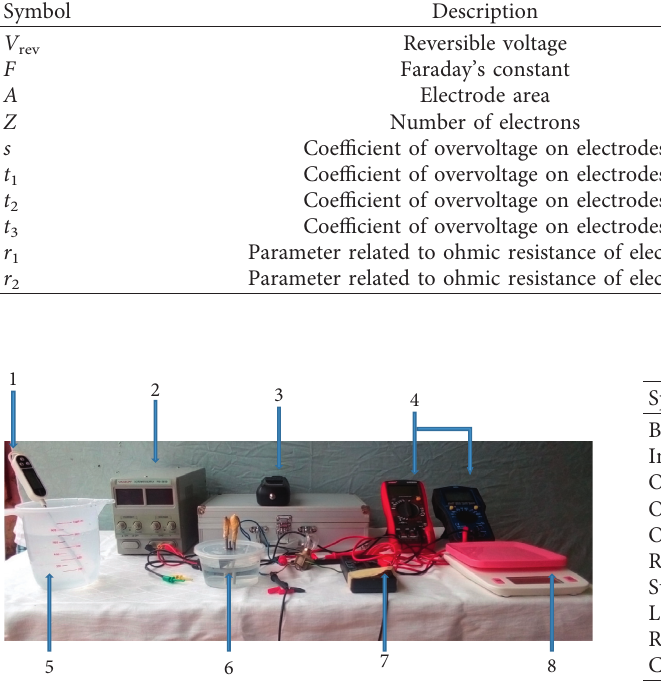
Figure 1: Elements of the experimental setup: (1) digital ther- mometer, (2) DC power supply, (3) hydrogen detector, (4) volt- meters, (5) plastic beaker, (6) cell, (7) ammeter, and (8.)scale balance.